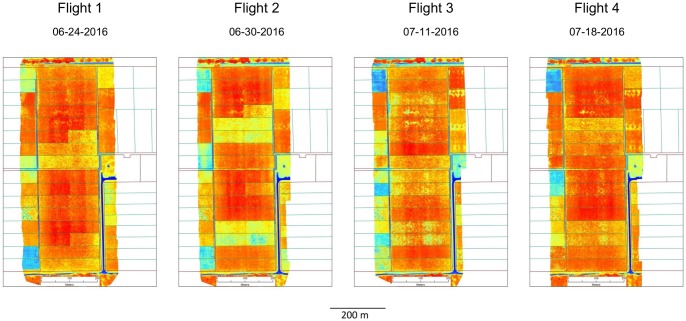
UAV-derived NDVI maps of grazed pasture of the KBS dairy farm (area of 15.6 ha) collected on four consecutive dates.Maps exhibit the spatial variability of high-resolution measurements (6 cm pixels) of pasture NDVI (-1: blue to 1: red color) in two blocks of eight 1-ha paddocks (200 x 50m) used for rotational grazing with lactating dairy cows.